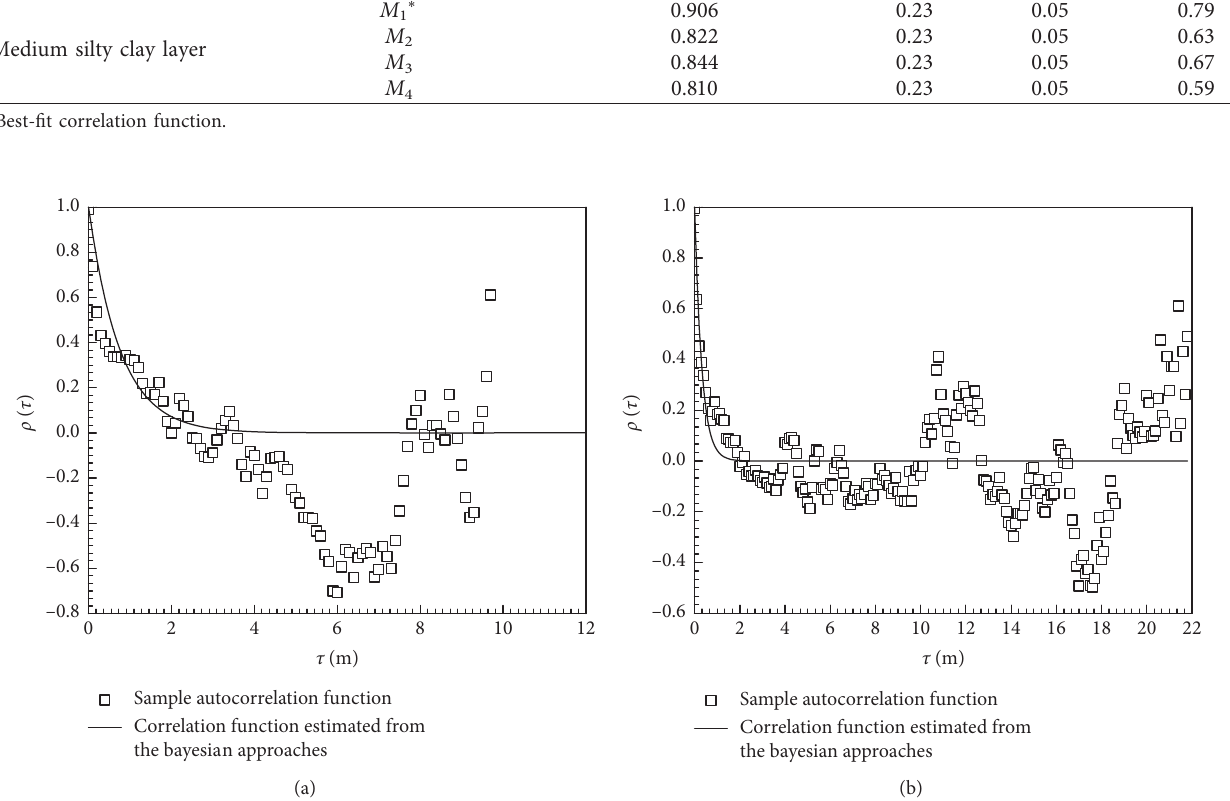
Figure 6: Comparison of correlation functions estimated from the Bayesian approaches and the sample autocorrelation function. (a) Medium clay layer. (b) Medium silty clay